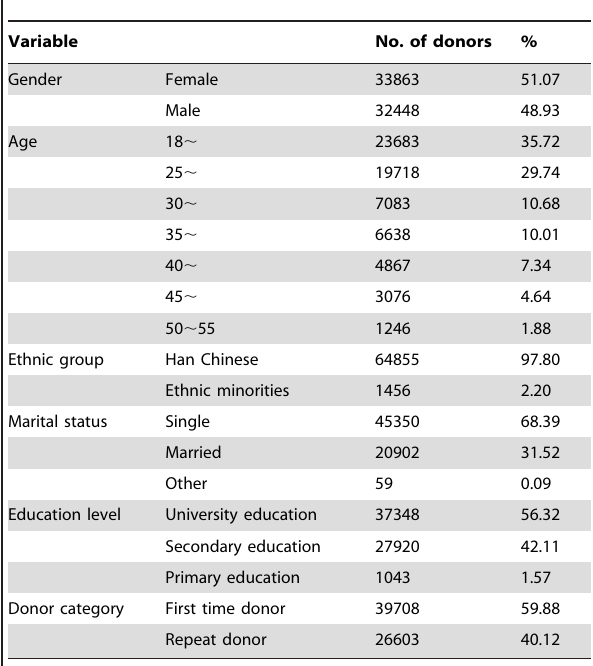
Table 2. Demographic characteristics of blood donors